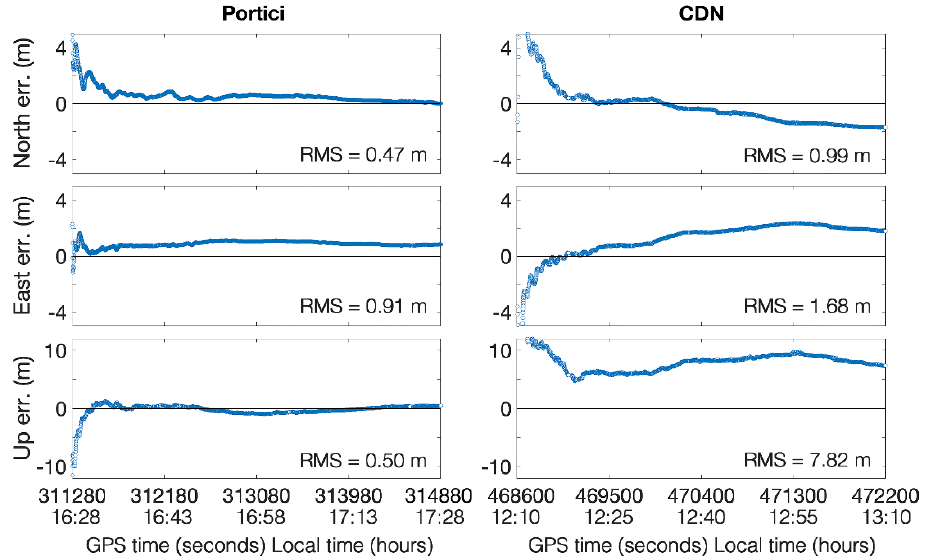
Figure 7. Carrier-based static positioning solution components performances for Portici ( left column) and CDN ( right column) sites.